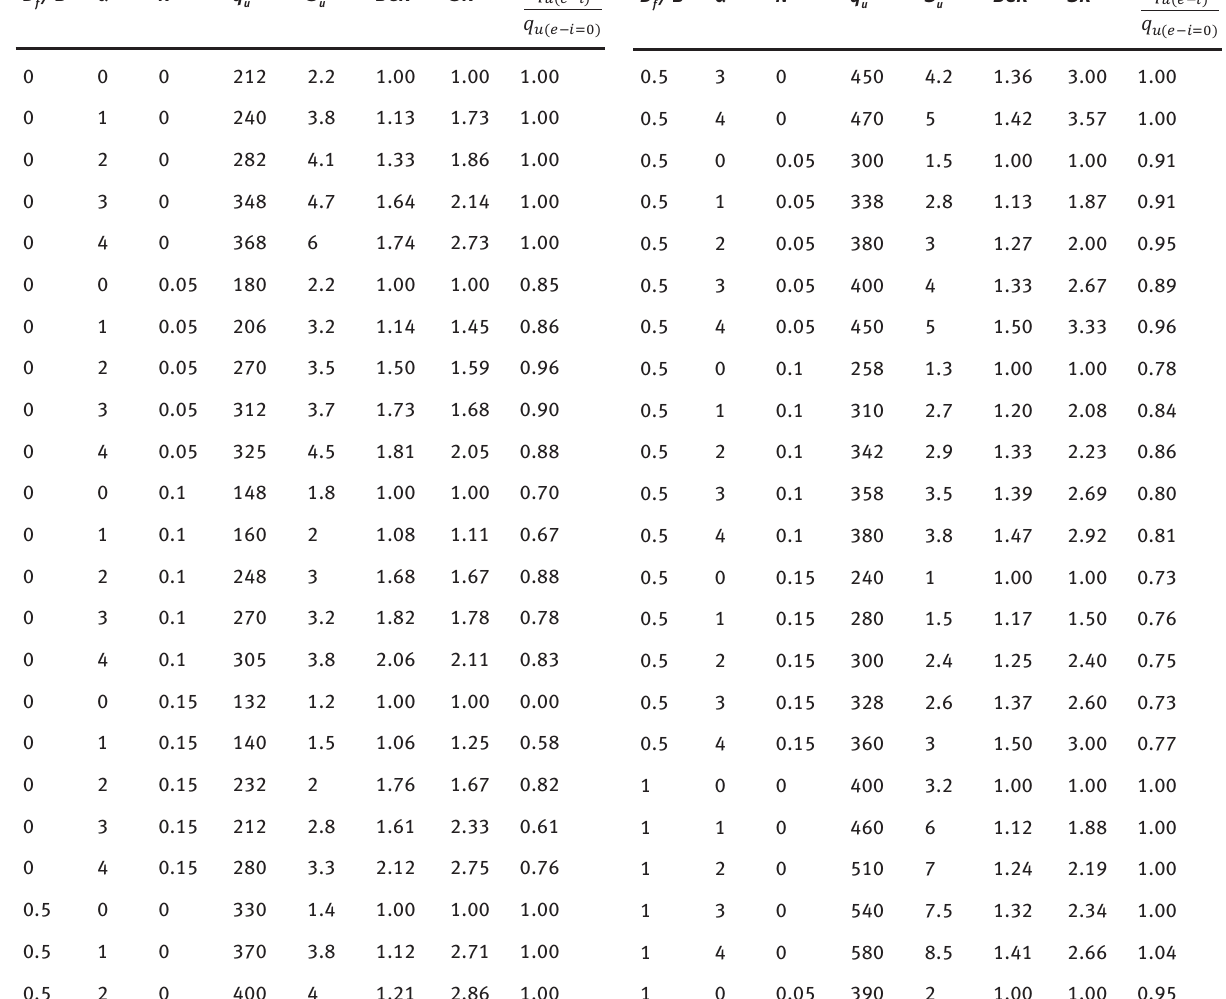
Table 3: Results of eccentrically loaded ( e/B ) rectangular footing in unreinforced and reinforced sand conditions. ⁄ D f